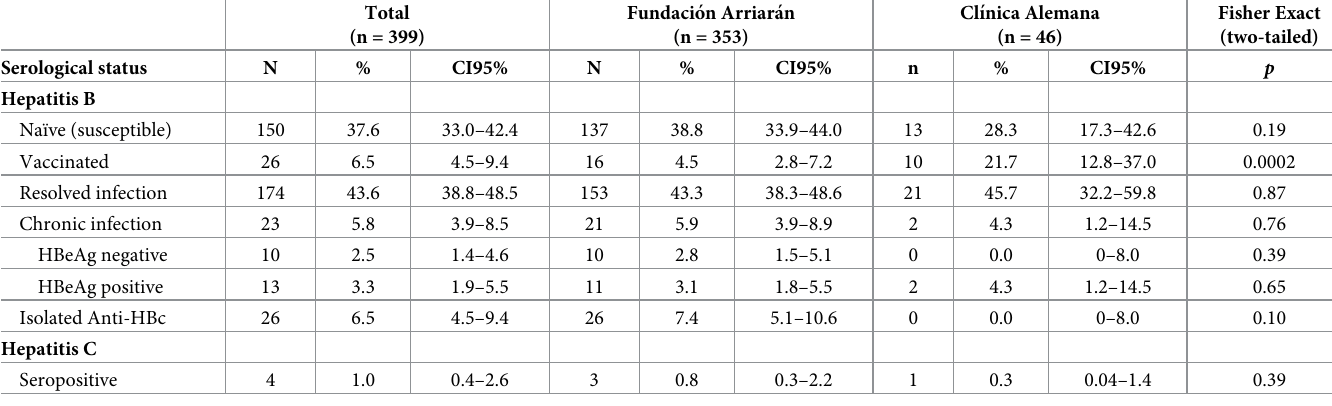
Table 3. Prevalence of HBV and HCV serological status of patients with HIV in